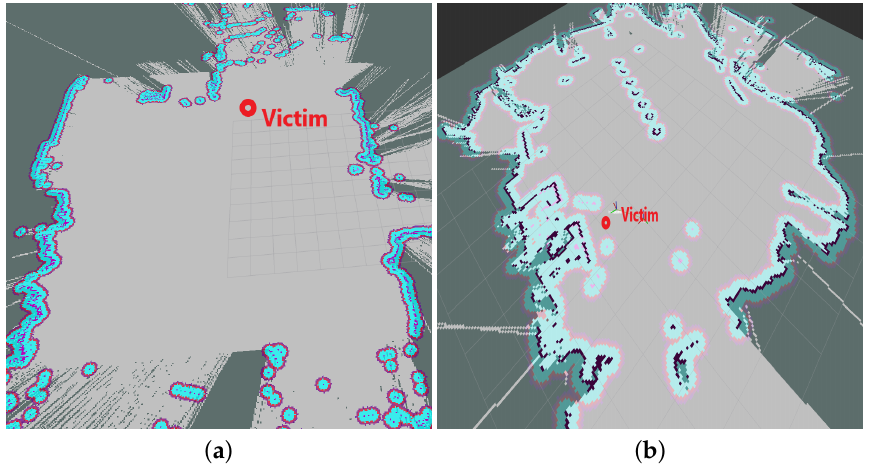
Figure 17. Victims location in the mapped environment. ( a ) Victim detection in reconstructed Scenario 1. ( b ) Victim detection in reconstructed Scenario 2. Source: